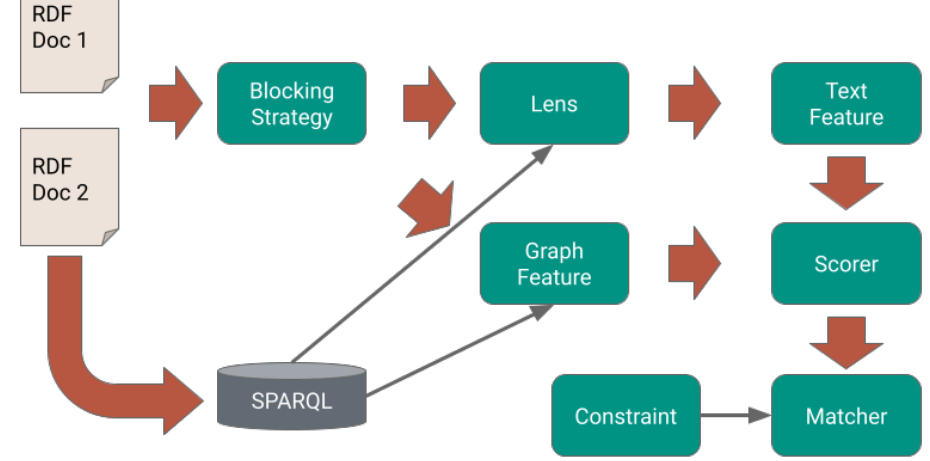
Figure 2. The architecture of the Naisc system for taxonomy